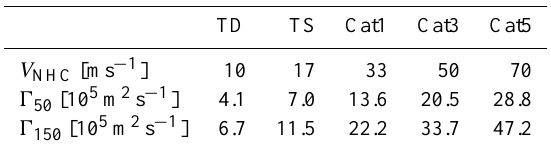
Table 1. Definition of model vortices based on NHC TC